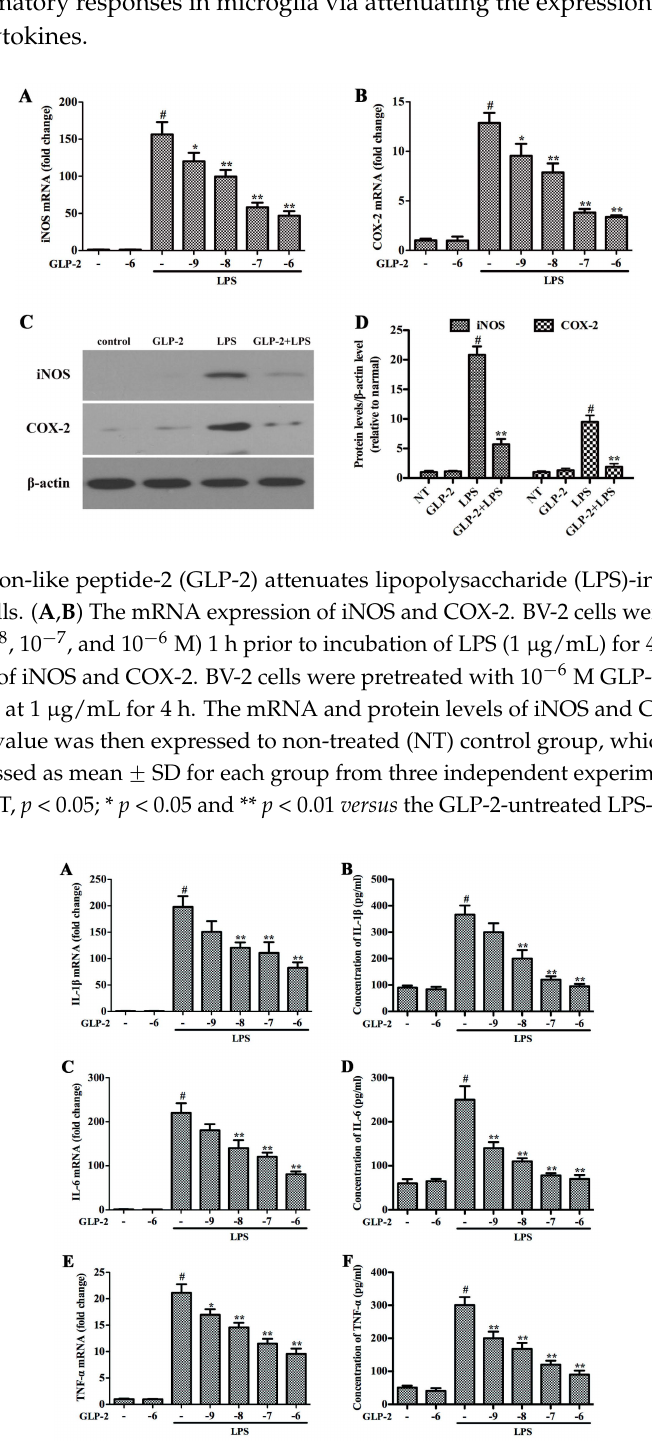
Figure 2. Effects of GLP-2 on LPS-induced expression of proteins and mRNA for IL-1 β , IL-6 and TNF- α in BV-2 cells. BV-2 cells were pretreated with GLP-2 (10 ´ 9 , 10 ´ 8 , 10 ´ 7 , and 10 ´ 6 M) 1 h prior to incubation of LPS (1 µ g/mL) for 4 h (mRNA) or 24 h (protein). Proteins and mRNA of IL-1 β ( A , B ); IL-6 ( C , D ) and TNF- α ( E , F ) were determined by quantitative real-time PCR and ELISA. Results are expressed as mean ˘ SD for each group from three independent experiments. # Significant compared with control (NT) alone, p < 0.05; * p < 0.05 and ** p < 0.01 versus the GLP-2-untreated LPS-stimulated